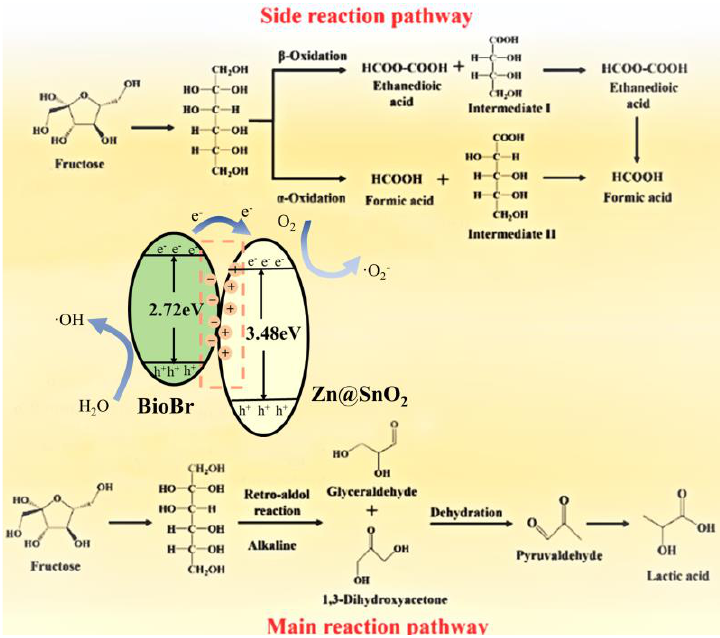
Figure 9. Possible reaction pathways of fructose photostimulation.